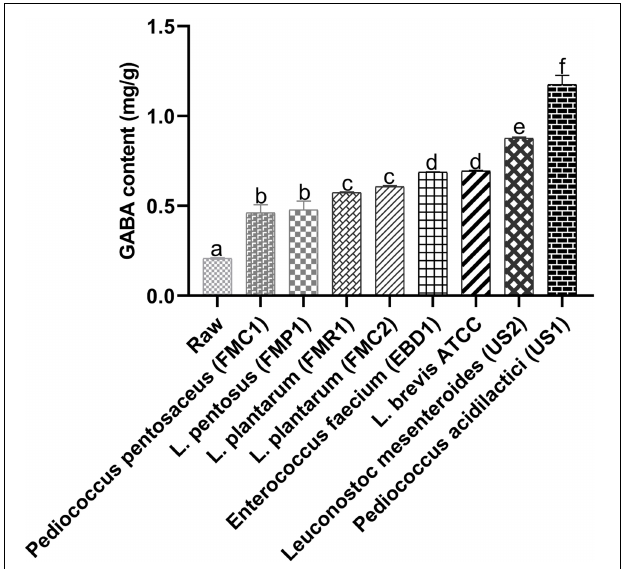
FIGURE 1 | Screening of different LAB strains (48 h fermentation) based on gamma-aminobutyric acid (GABA). The sample concentration was 1 mg/mL; the values represent triplicate readings (mg/g) mean ± SD, and superscripts with different letters indicate a level of significance ( p <